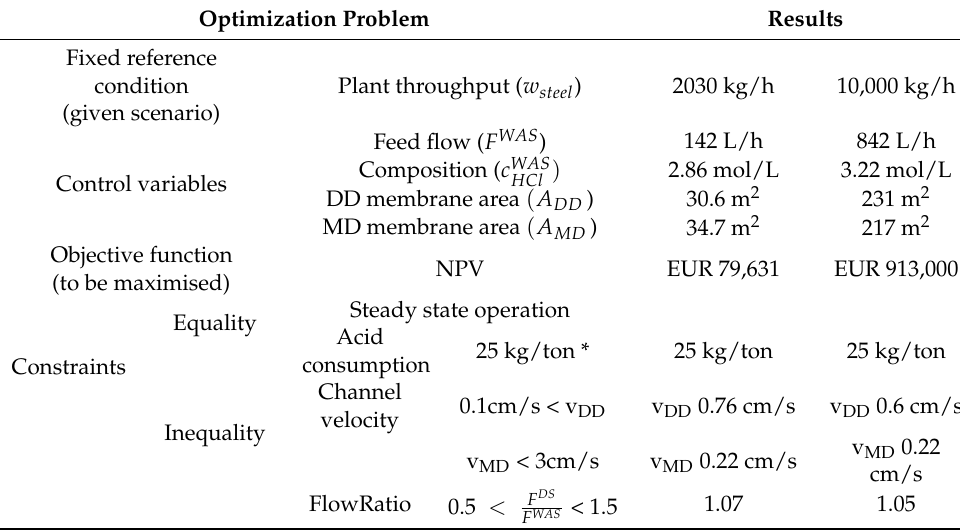
Table 9. Optimization problem and results for the scenario with operating + design variables as control